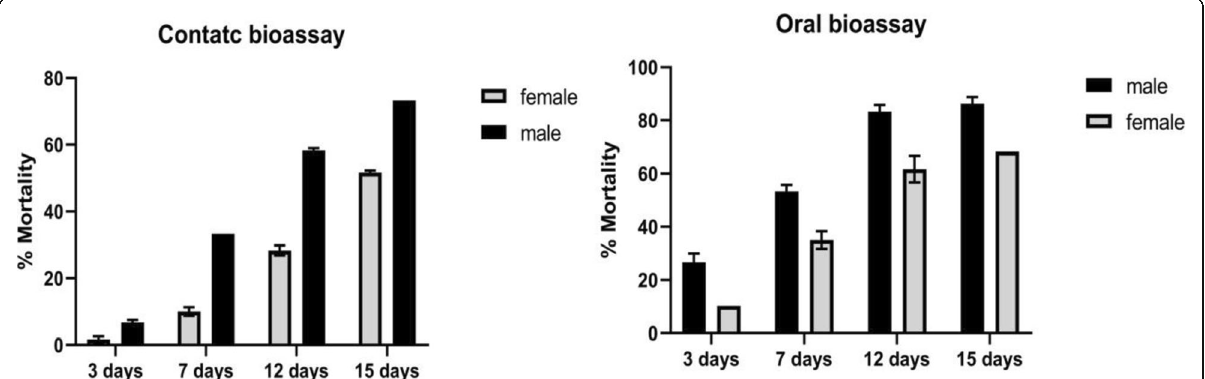
Fig. 4 Virulence and mortality responses of Ceratitis capitata adults treated as oral (the right figure) and contact (the left figure) bioassay with Beauveria bassiana BAUM